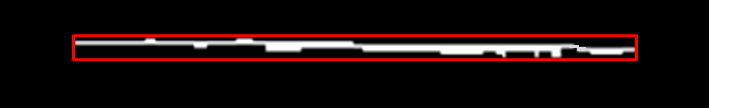
Figure 5. A sample thresholded u-depth map with a segmented obstacle and corresponding bound- ing